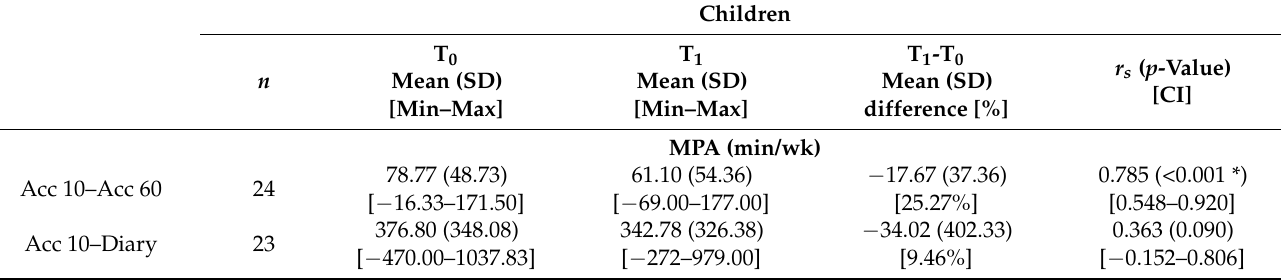
Table 3. Stability of differences as calculated by Spearman’s rho ( r s ) for children. Displayed are the number of participants ( n ), mean differences between the measurement (Mean), their standard deviations (SD), and their minimum (Min) and maximum (Max) values at two measurements three weeks apart (T 0 and T 1 ) as well as the differences in the error between T 1 and T 0 as mean, SD, and percentage (%). Additionally, r s with corresponding p -value (* for p < 0.05) and 95% confidence interval via bootstrapping (CI) for differences between the measurement tools: accelerometry with 60-s epoch length (Acc 60) and 10-s epoch length (Acc 10), physical activity diary (Diary) for moderate (MPA) and vigorous (VPA) physical activity.